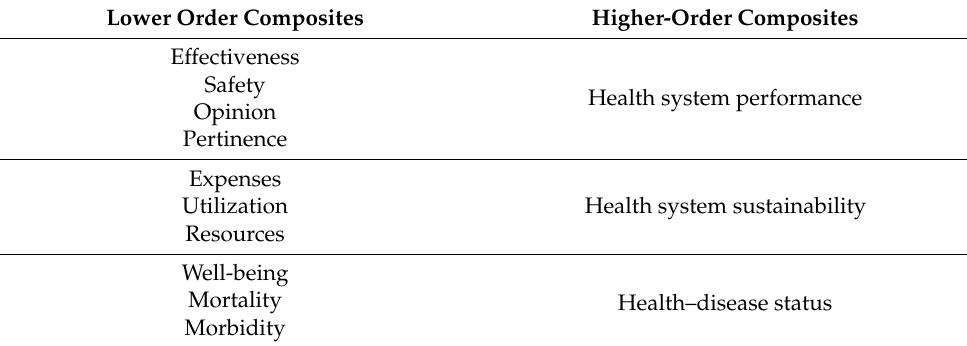
Table 2. Hierarchical component of